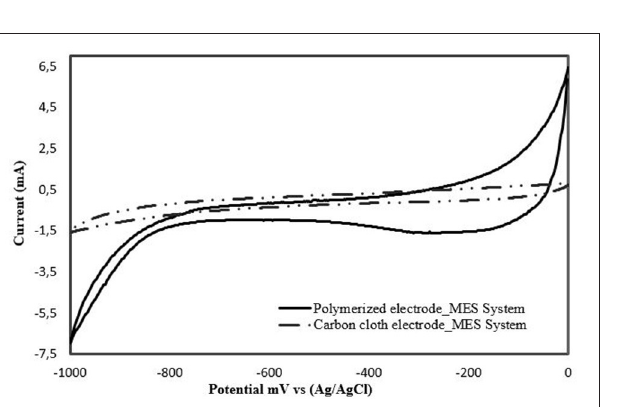
FIGURE 5 | Cyclic voltammograms obtained at a carbon cloth and a PEDOT:PSS-carbon cloth electrode (polymerized) in S. ovata -driven MES reactors. Scan rate of 1mV s − 1